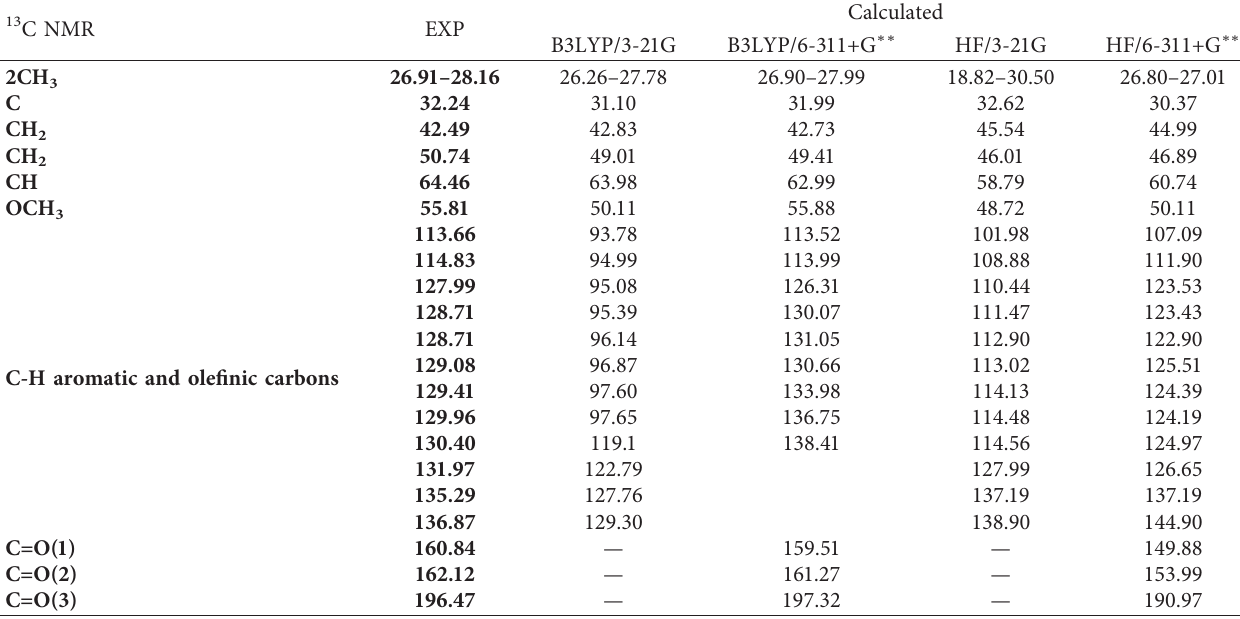
Table 6: Experimentally measured and calculated 13 C chemical shifts δ (ppm vs TMS) of the compound (5a) . 13 C NMR